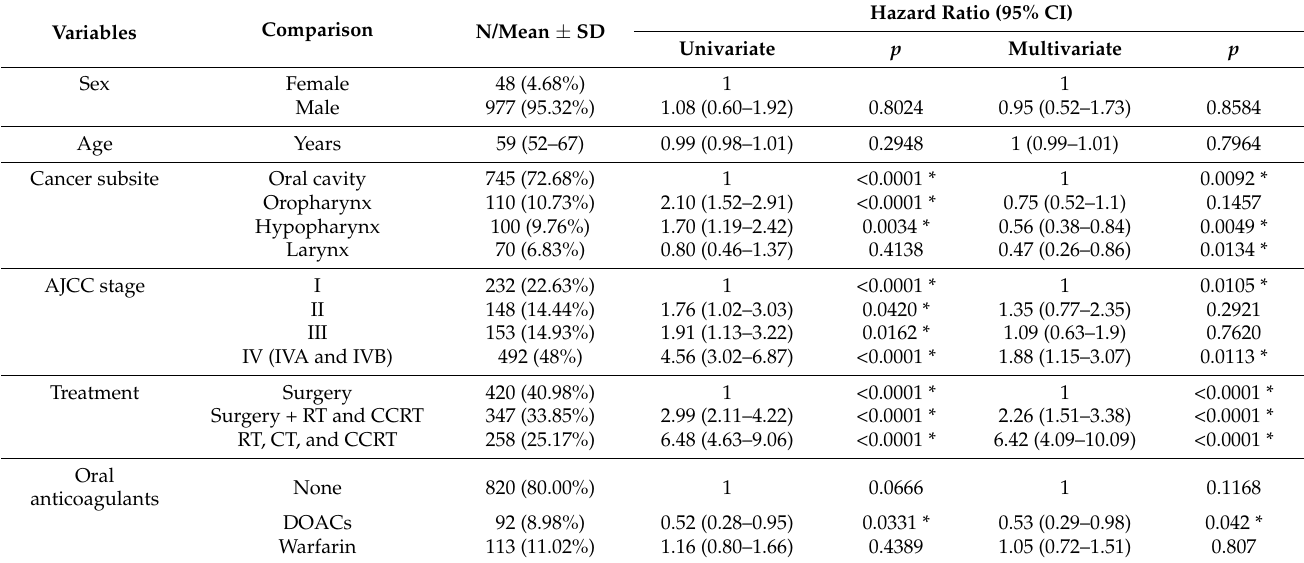
Table 4. Univariate and multivariate Cox regression model of prognostic factor for disease specific survival in study cohort ( n = 1025).